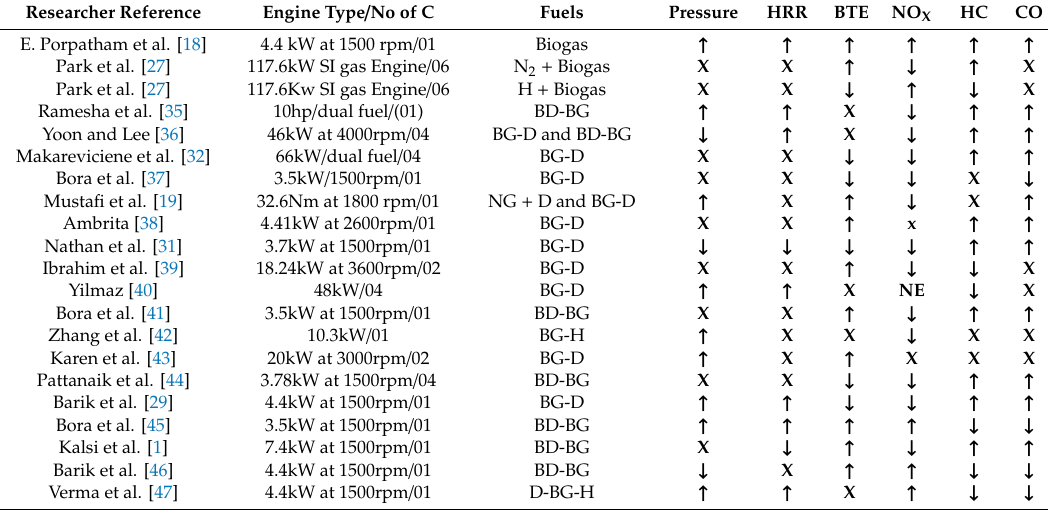
Table 1. Reviews of research work on the usage of